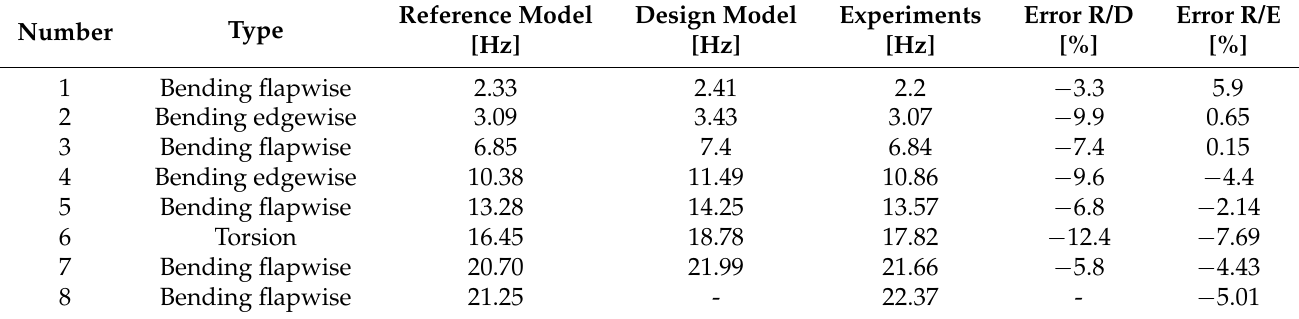
Table 9. Eigenfrequencies of the clamped rotor blade simulated in